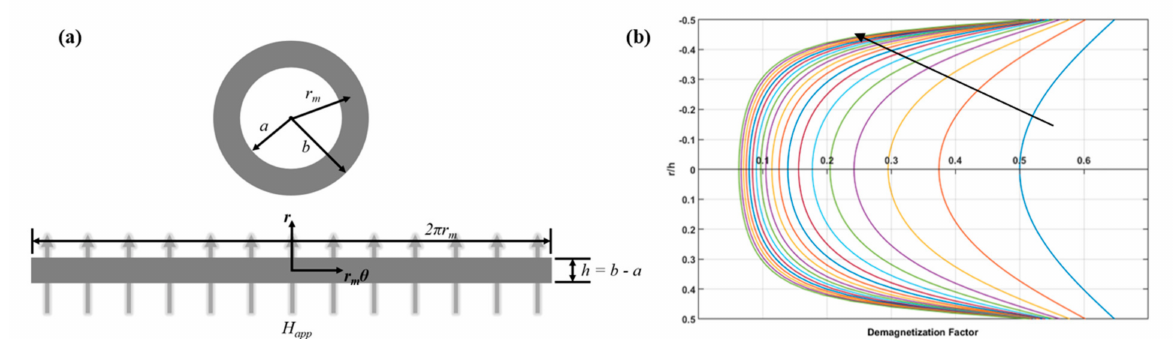
Figure 2. ( a ) Schematic of (top) the inner piezomagnetic cylinder with its defining geometrical parameters and (bottom) prism resulting from unfolding the cylinder along its circumference, and ( b ) the calculated demagnetization factor as function thickness (arrow indicate increasing thickness from 0.002 to 0.02 m) based on Equation (12).